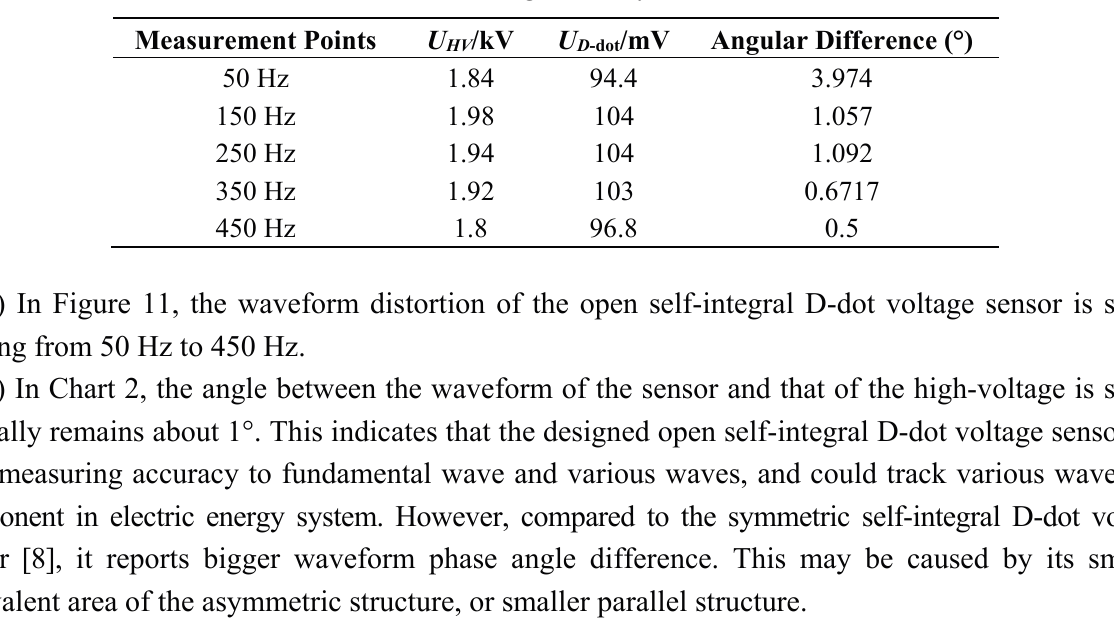
Table 2. Measuring accuracy of harmonic.